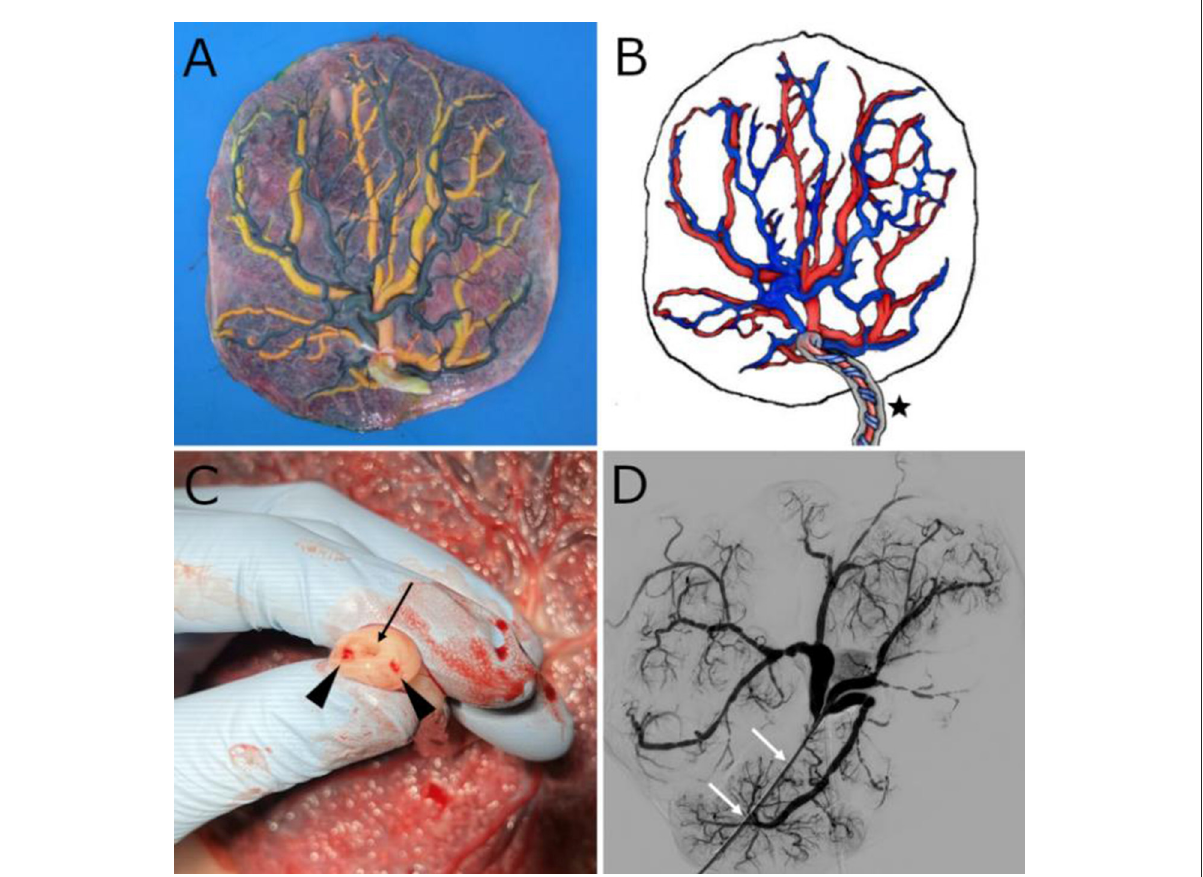
FIGURE1 (A) Fresh placenta after removal of the amniotic sac and injection of color-dye into the chorionic plate vessels. Yellow vessels correspond to veins and dark green ones to arteries. (B) Schematic representation of a human placenta. The umbilical cord (black star) contains a vein and two arteries that spiral around it, buried within Wharton’s jelly. The veins, which carry oxygenated blood, are shown in red, and the arteries in blue. (C) Umbilical cord cross-section with two umbilical arteries (black arrowheads) and a single umbilical vein (black arrow). (D)